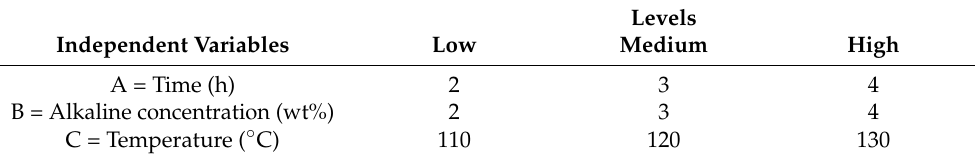
Table 1. Variables of alkali pretreatment in the orthogonal design.